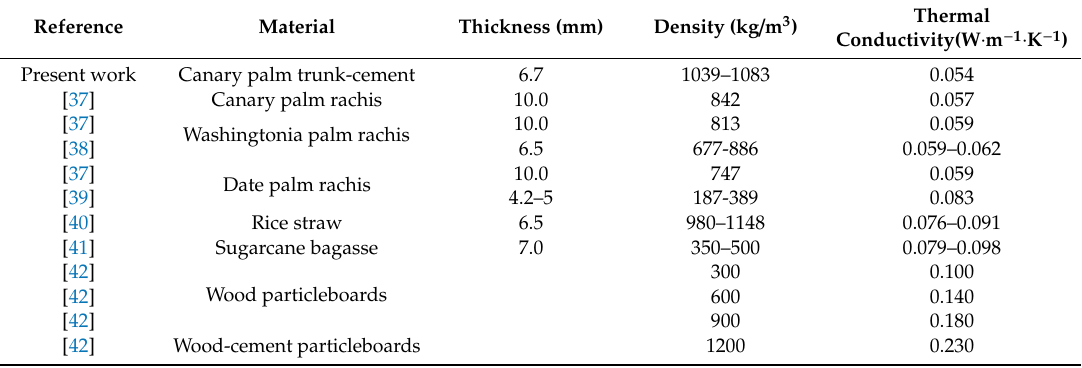
Table 2. Thermal conductivity obtained in different tests with plant fibre boards and wood